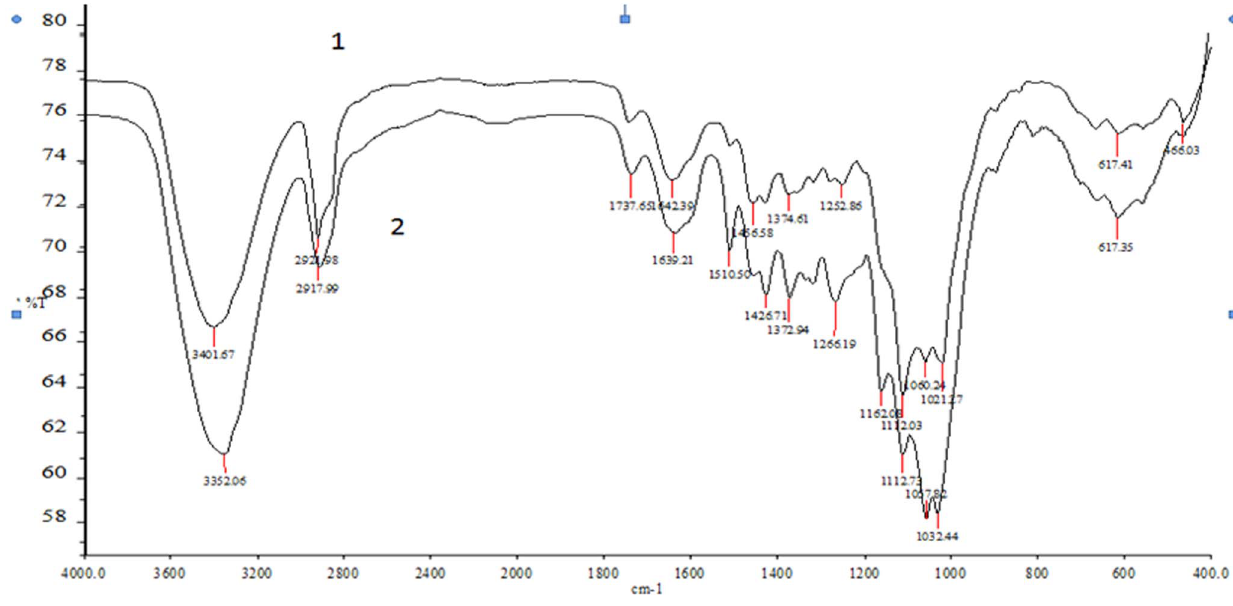
Figure 4. FTIR spectra of (1) P-C (2) P-X-L-C treated ONP pulp. doi:10.1371/journal.pone.0072346.g004 PLOS ONE |